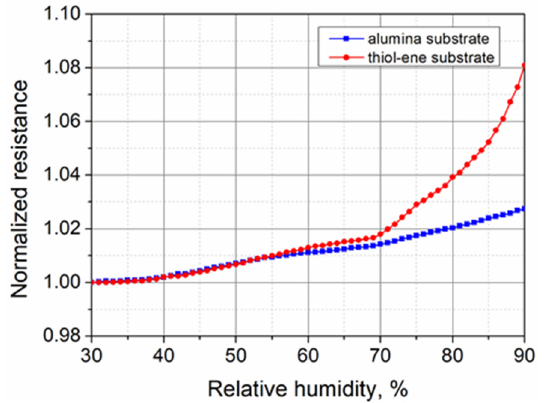
Figure 13. Normalized resistance of PEDOT:PSS films on alumina and thiol–ene substrates versus relative humidity.